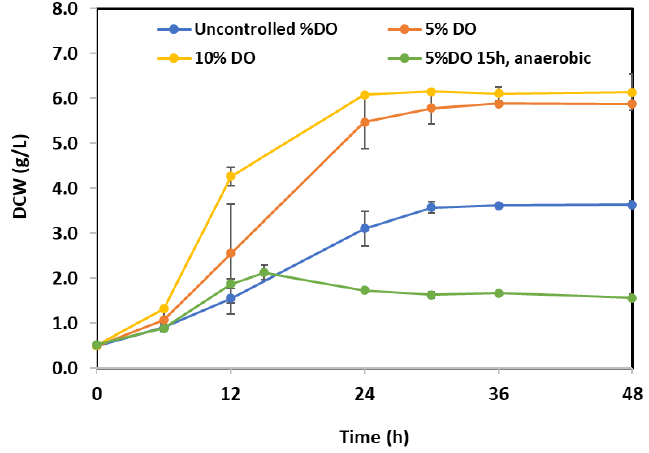
Figure 1. Cell growth of B. subtilis at 30 ◦ C, pH 6 in a 2 L benchtop bioreactor under different DO control strategies: controlling DO with cascade agitation at 5%, controlling DO with cascade agitation at 10%, uncontrolled DO at fixed stirrer speed at 180 rpm throughout fermentation, controlling DO with cascade agitation at 5% during the first 15 h, followed by anaerobic conditions.